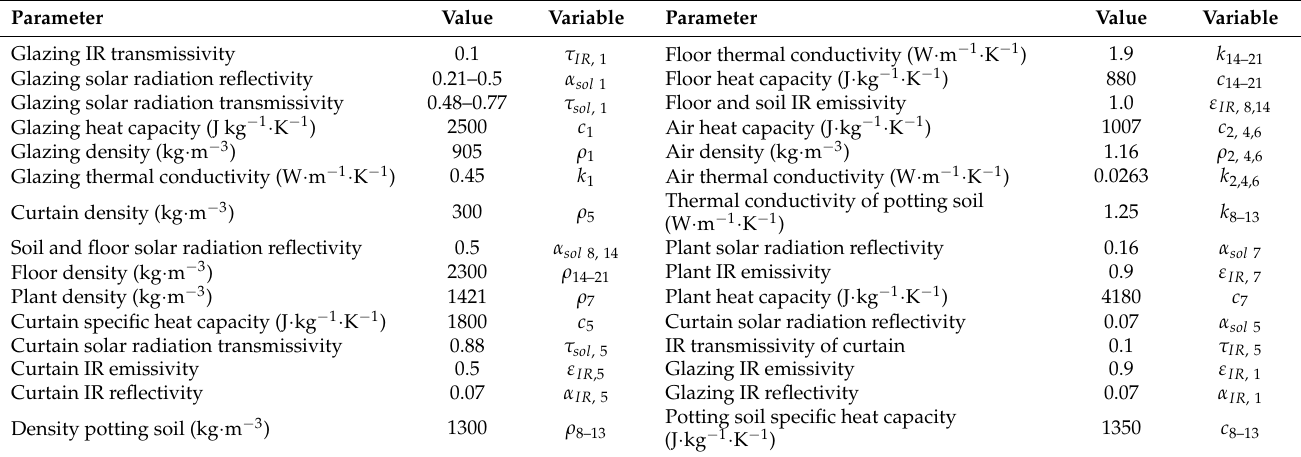
Figure 2. Model layers and heat transfer pathways. Arrows point in positive directions. Table 2. Summary of parameters used in the model.